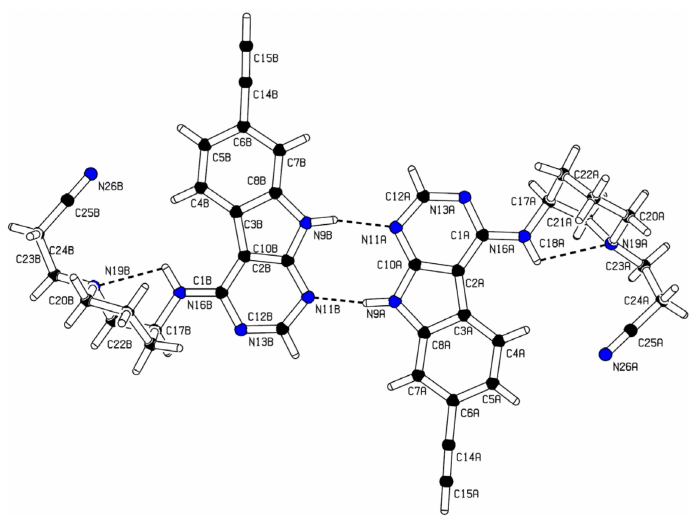
Figure 2. X-ray crystal structure of title compound 2